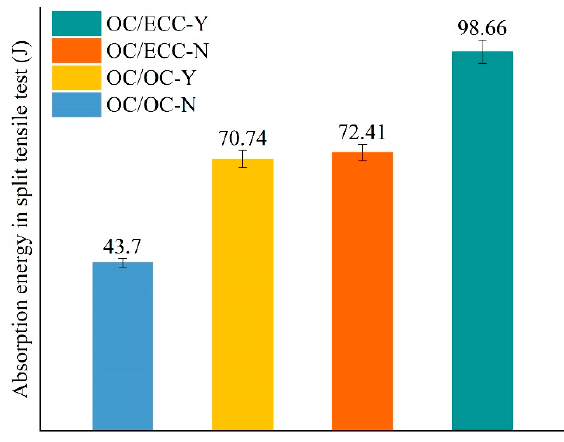
Figure 15. Absorption energy in the split tensile test of each group.